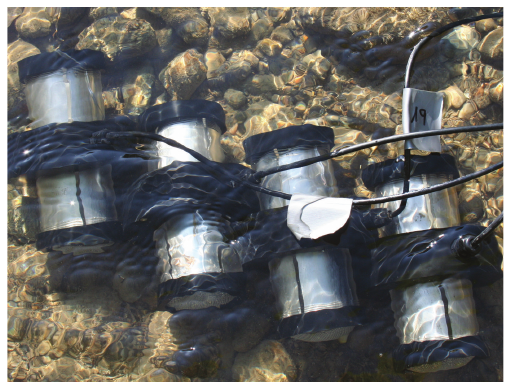
Figure 2: Experimental setup in situ (Photo: A. Gerhardt). View from top: four test chambers (15 × 5 cm) are placed on the sediment of the stream in flow direction, attached with ropes to steel poles in the sediment and on the banks. Each chamber contains 10 gammarids and 2 elder leaves. The test chambers can be connected to the